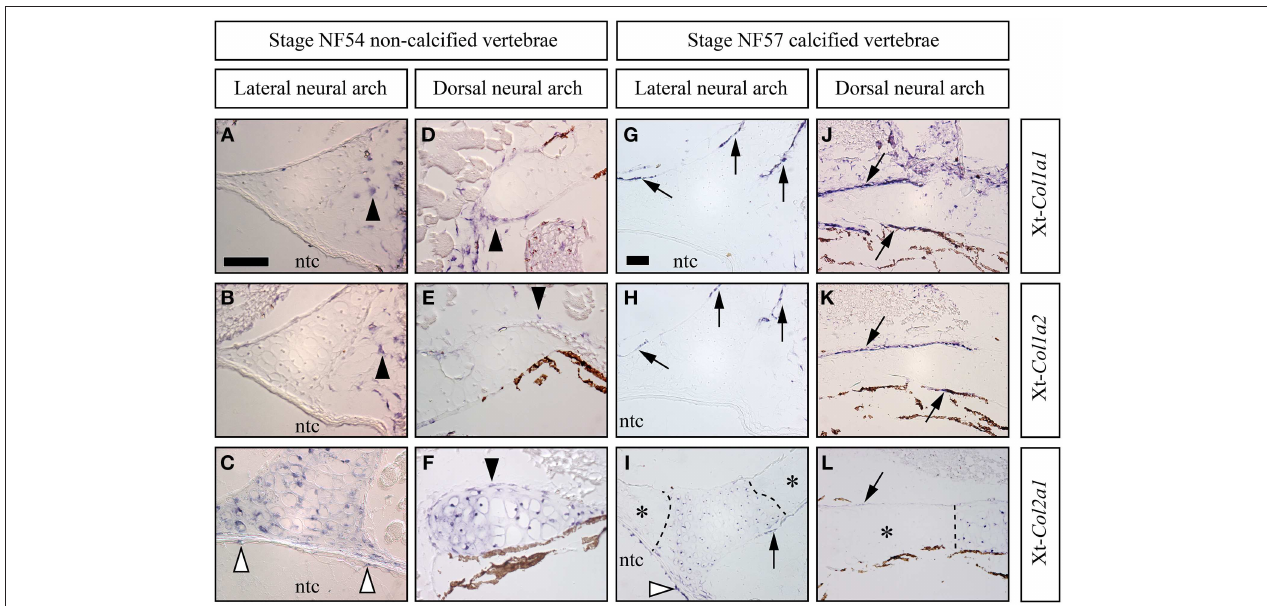
FIGURE 5 | Skeletal expression patterns the Xt- Col1a1 , Xt- Col1a2 , and Xt- Col2a1 during Xenopus tropicalis vertebrae development. Transverse sections of stage NF54 (A–F) and NF57 (G–L) vertebrae processed for in situ hybridizations using the Xt- Col1a1 , Xt- Col1a2, and Xt- Col2a1 probes, as indicated. Black arrowheads show loose (A,B) or perichondral (D–F) cells. White arrowheads in (C,I) show Xt-Col2a1 positive epithelial non-vacuolated cells of the notochord. Arrows point at osteoblasts expressing Xt- Col1a1 (G,J) , Xt- Col1a2 (H,K), or Xt- Col2a1 (I,L) . In (I,L) , calcified, Alizarin red-positive cartilaginous regions are marked by an asterisk and the dotted lines demarcates expression boundaries between Xt-Col2a1 positive and Xt-Col2a1 negative chondrocytes. In situ hybridization signal is light to dark blue. Brown endogenous X.t. pigment cells are also visible in the vicinity of the dorsal neural arch (D–F, J–L) . Scale bar in (A) represents 50 µ m in (A–F) ; scale bar in (G) represents 50 µ m in (G–L)